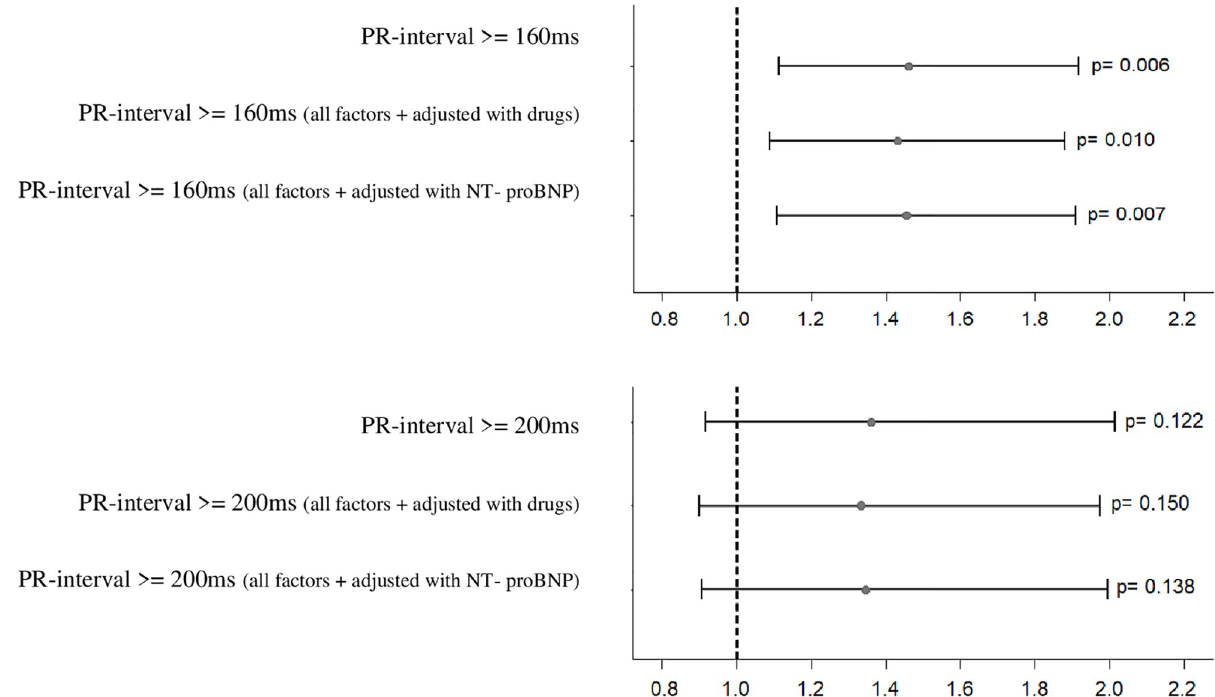
Fig 2. Multivariable analysis. Six multivariable models with 2 different cut-offs adjusted for clinically relevant factors for WMHs. Model 1: PR interval (cut-off 160 ms) adjusted for previous stroke, systolic and diastolic blood pressure; Model 2: Model 1 with further adjustment for cardiac medication; Model 3: Model 1 with further adjustment for NT-proBNP; Model 4: PR interval (cut-off 200 ms) adjusted for previous stroke, systolic and diastolic blood pressure; Model 5: Model 4 with further adjustment for cardiac medication; Model 6: Model 4 with further adjustment for NT-proBNP. PR interval � 160 ms was associated with WMHs in all the multivariable models, whereas PR interval � 200 ms was not. Odd’s ratio with 95% confidence interval and the respective P-value are